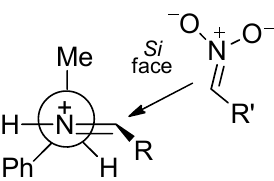
Figure 2. Stereoselective intermolecular attack.